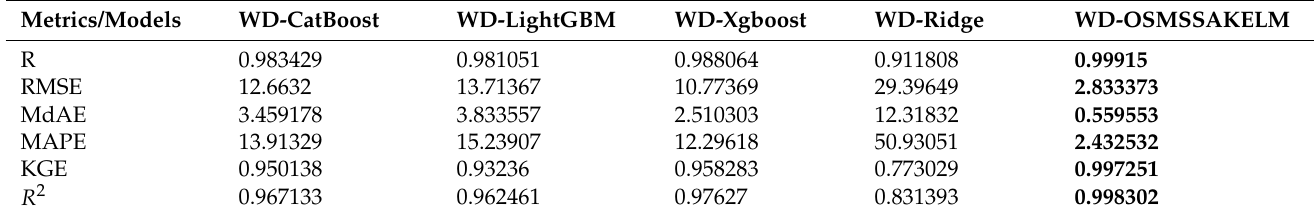
Table 5. Comparison results of the proposed model for training phase versus other studied models based on different metrics.